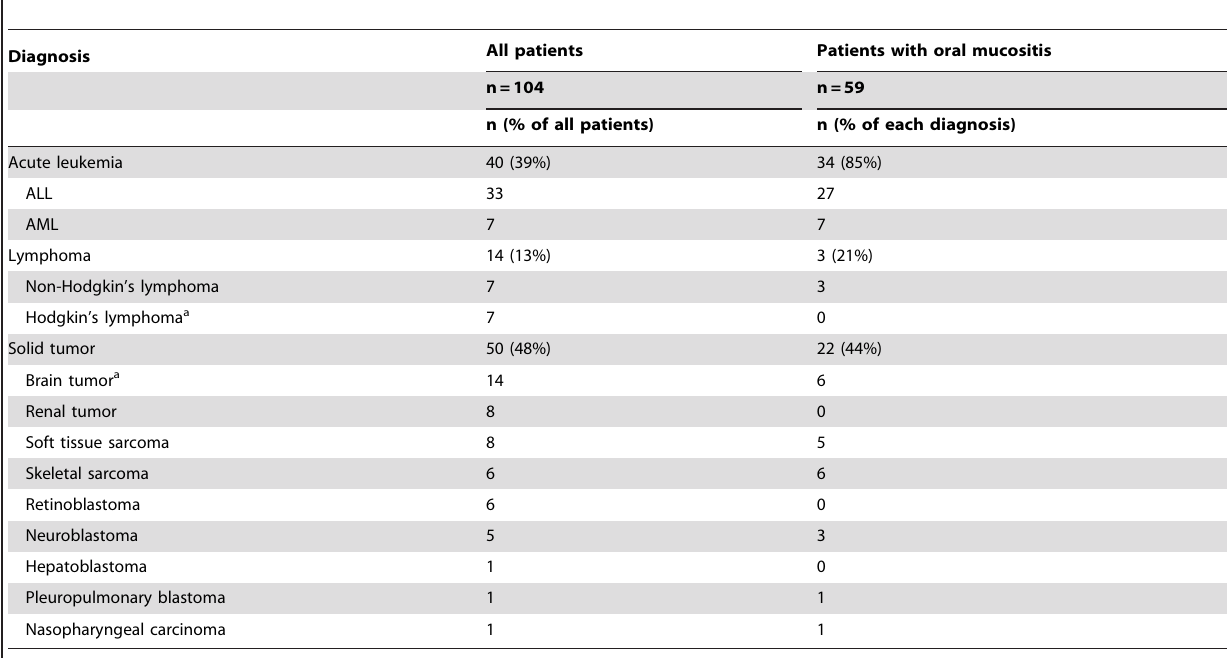
Table 1. Diagnoses of the patients and frequencies of oral mucositis.